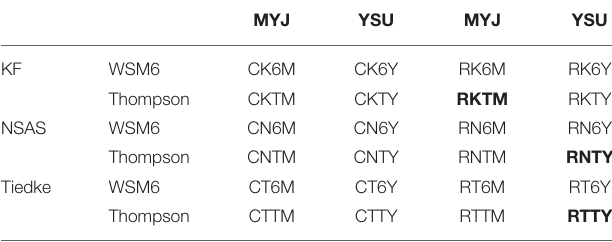
TABLE 3 | The physics combination of the WRF36 ensemble that used ERA-Interim between 1990–2000 as driving